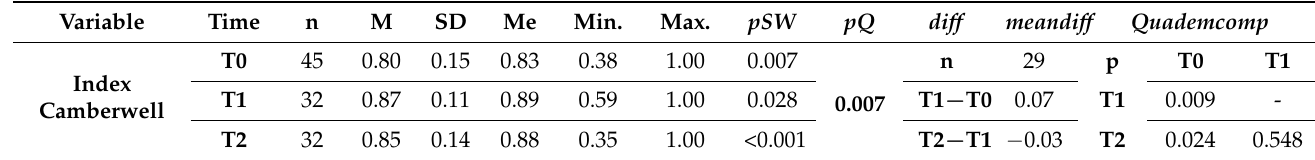
Table 4. The level of satisfaction of needs in the complex group G3 at the time T0, T1,